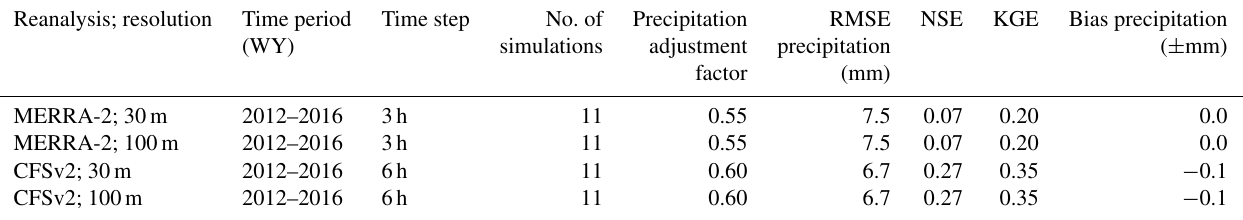
Table D1. Precipitation adjustment factor results. The best precipitation adjustment factors are shown, along with the root mean squared error (RMSE), the Nash–Sutcliffe efficiency (NSE), the Kling–Gupta efficiency (KGE), and the mean bias error (bias).